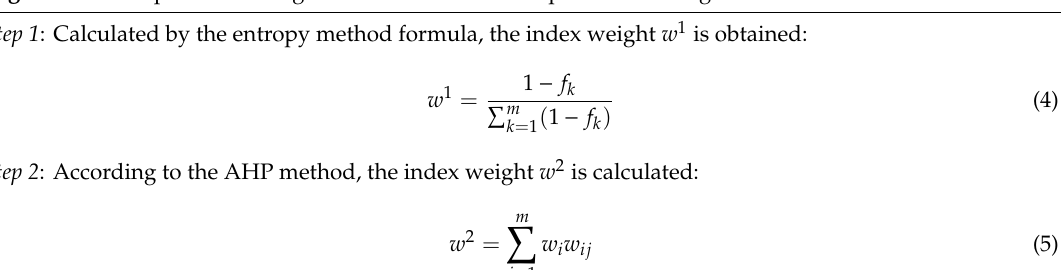
Algorithm 1: Empowerment algorithm for balanced comprehensive